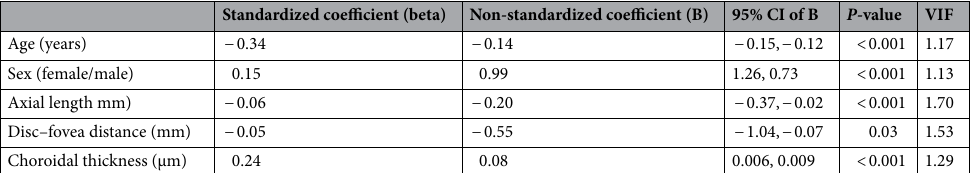
Table 5. Associations between the thickness of the photoreceptor outer segment band (POS), with ocular and systemic parameters in a multivariable analysis. The band thickness was calculated as the mean value of all 9 Early Treatment Diabetic Retinopathy Study (ETDRS) subfields. CI confidence interval, VIF variance inflation